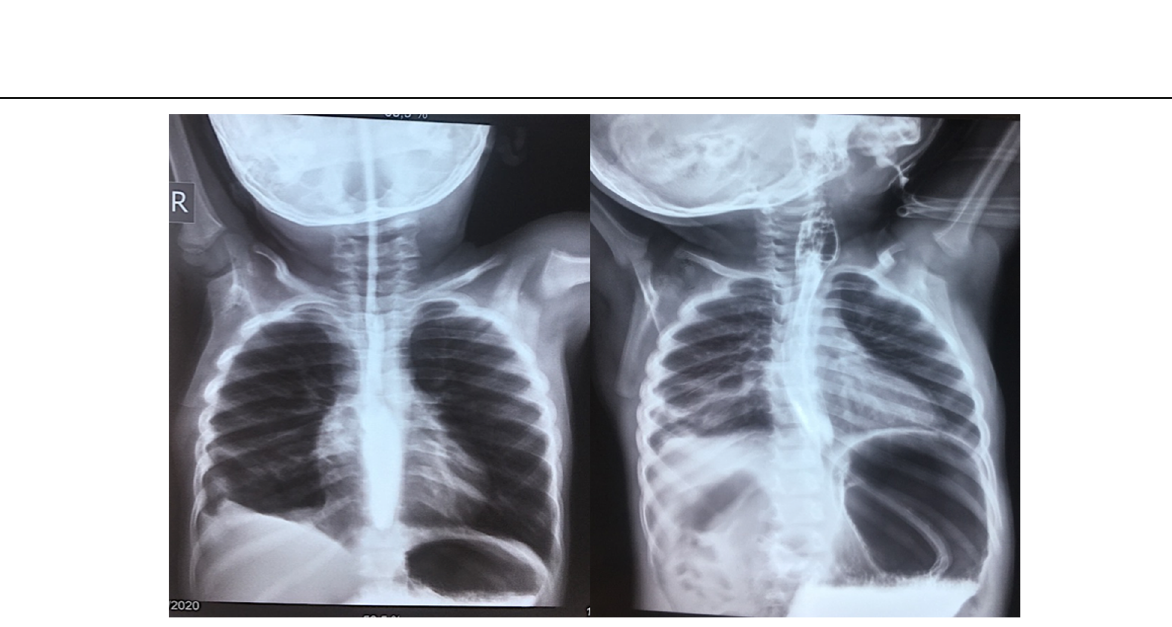
Fig. 5 Contrast esophagography revealed homogeneous opacification without detection of